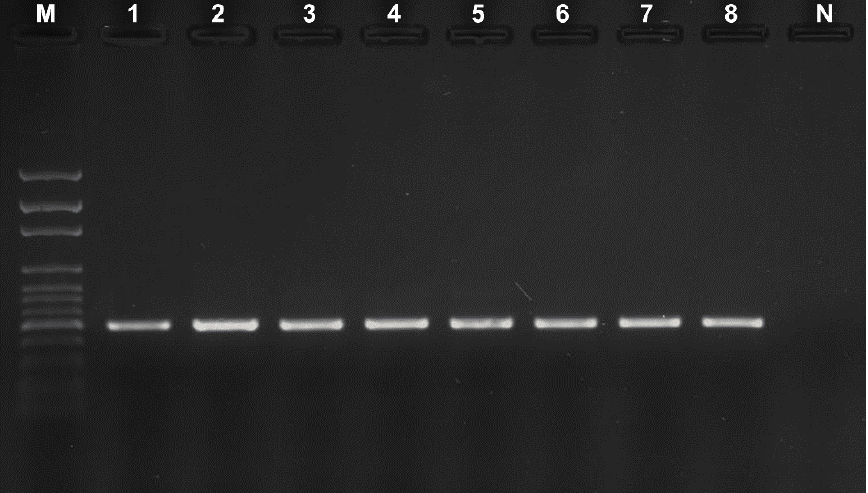
Figure 2. Detection of Alt a 1 gene in tested Alternaria strains. M—molecular weight marker from 100 bp to 3000 bp (Solis BioDyne, Tartu, Estonia), 1–7—tested Alternaria